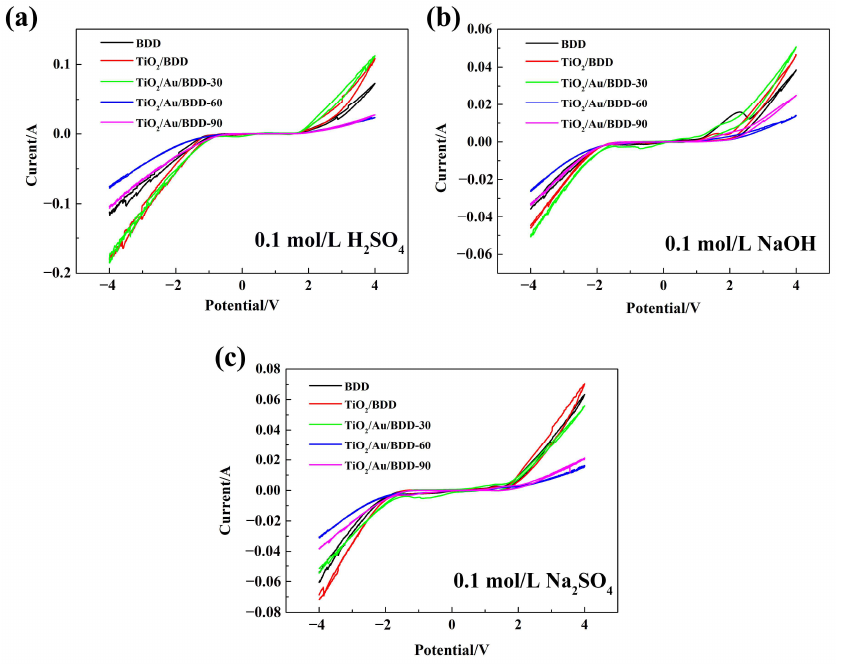
Figure 6. CV curves of the various electrodes in the different electrolytes with the scan rate of 200 mV/s: ( a ) 0.1 mol/L H 2 SO 4 , ( b ) 0.1 mol/L NaOH, and ( c ) 0.1 mol/L Na 2 SO 4 .